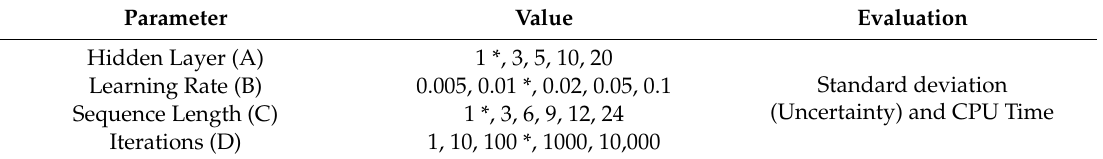
Table 4. Sensitivity analysis for LSTM for forecasting flood (*: reference value).